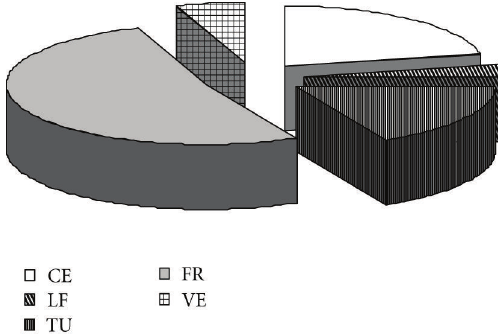
Figure 2: Diversity of food products in home gardens: cereals (CE), tubers (TU), leguminous food (LF), fruits (FR), and vegetables